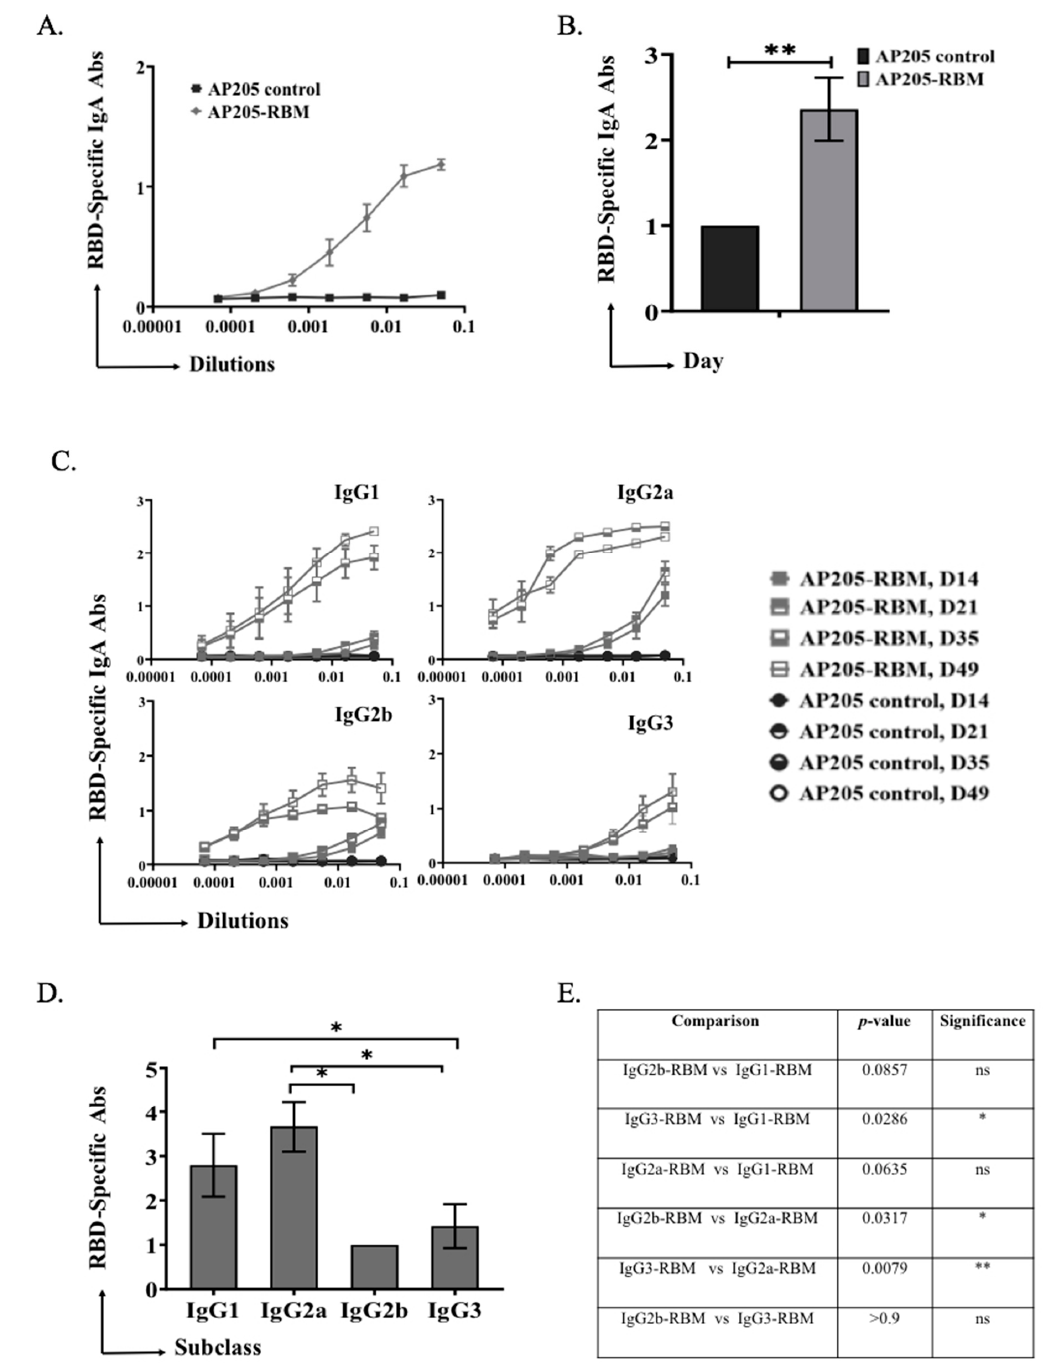
Figure 3. AP205-RBM vaccine promotes IgA production and IgG responses dominated by IgG2a. ( A , B ) RBD-specific IgA titers for the groups vaccinated with AP205 control and AP205-RBM vaccine on day 49, measured by ELISA (OD50 in B: given as reciprocal dilution values), three-fold serial serum dilution were used starting from 1:20. ( C ) RBD-specific IgG1, IgG2a, IgG2b, and IgG3 titer for the groups vaccinated with AP205 control and AP205-RBM vaccine on days 14, 21, 35, and 49 measured with OD450, three-fold serial serum dilution were used starting from 1:20. ( D ) RBD-specific IgG1, IgG2a, IgG2b, and IgG3 titers for the group vaccinated with AP205-RBM vaccine on day 49 measured by ELISA (OD50: given as reciprocal dilution values), three-fold serial serum dilution were used starting from 1:20. ( E ) A table summarizing the p . value when comparing the different IgG subclasses. One representative of 2 similar experiments is shown. The value of p < 0.05 was considered statistically significant (* p < 0.01, ** p <